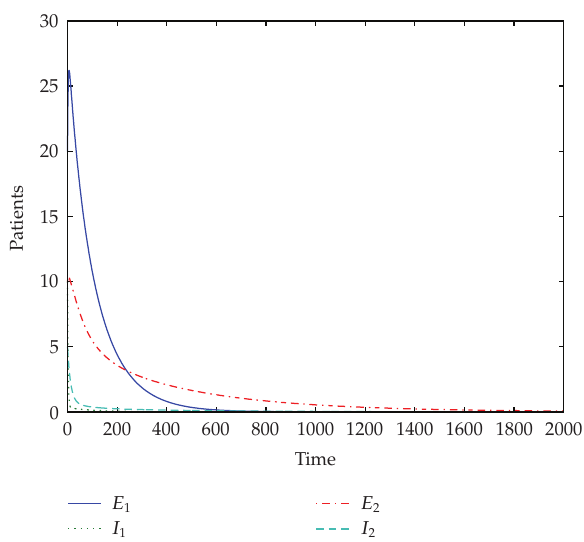
Figure 5: Trajectories of system (cid:2) 2.2 (cid:3) when β 1 (cid:2) N (cid:3) (cid:8) β 1 , β 2 (cid:2) N (cid:3) (cid:8) β 2 , β 1 (cid:8) β 2 (cid:8) 0 . 001, d 1 (cid:8) 0 . 02, d 2 (cid:8) 0 . 07, so that R 1 < 1, R 2 < 1. It shows that the disease-free equilibrium P 0 is stable.